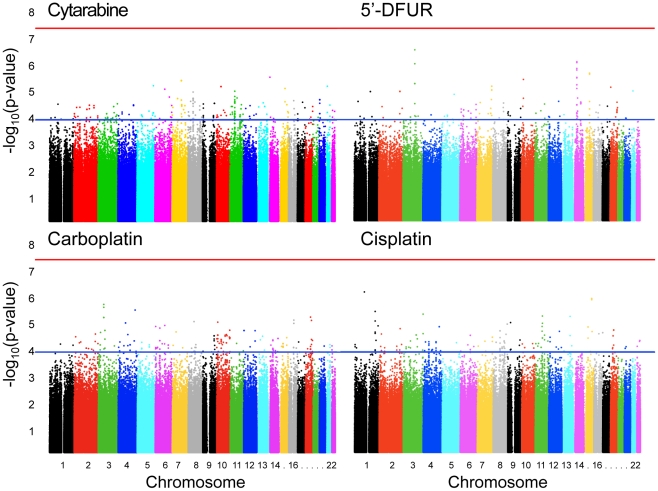
Genome-wide association results for chemotherapeutic-induced cytotoxicity in the ASW.Each point represents a SNP. Blue lines are at the suggestive significance threshold of p = 10−4. Red lines are at the genome-wide significance threshold of p = 5×10−8.